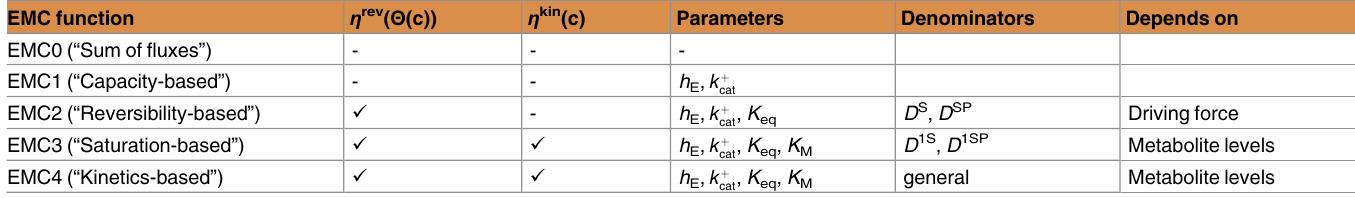
Table 2. Simplified enzyme cost functions. By omitting some terms in Eq (5), we obtain a number of cost functions with simple dependencies on enzyme parametersand metabolitelevels. Terms marked by ✓ appear explicitly in the rate and cost formulae, while other terms are omitted or set to constant values. The EMC0 function yields the sum of fluxes, EMC1 functions contain enzyme-specific flux burdens based on k cat and h values (i.e., replacingreaction rates by their maximal velocities). EMC2 depends on metabolitelevels only via the driving forces. EMC3 functions are based on simplified rate laws, and EMC4 functions capture all rate laws, possibly includingallostericregulation.The rate law denominators D S , D SP , D 1S , and D 1SP , and the EMC functions them- selves are describedin Table A in S1 Text. EMC